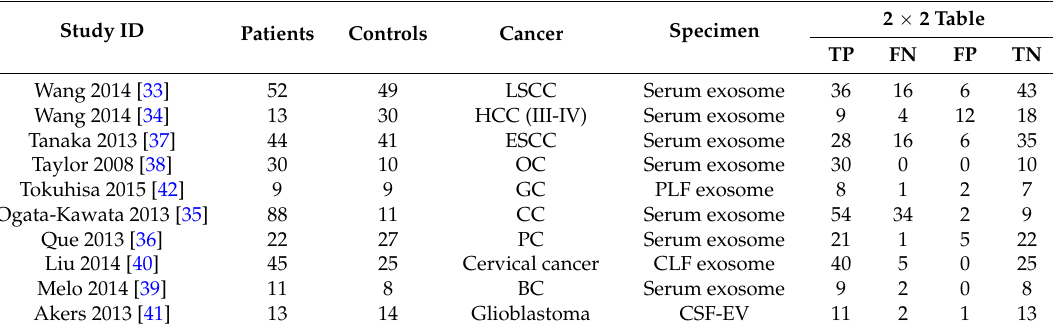
Table 1. Characteristics of diagnostic clinical studies included in this